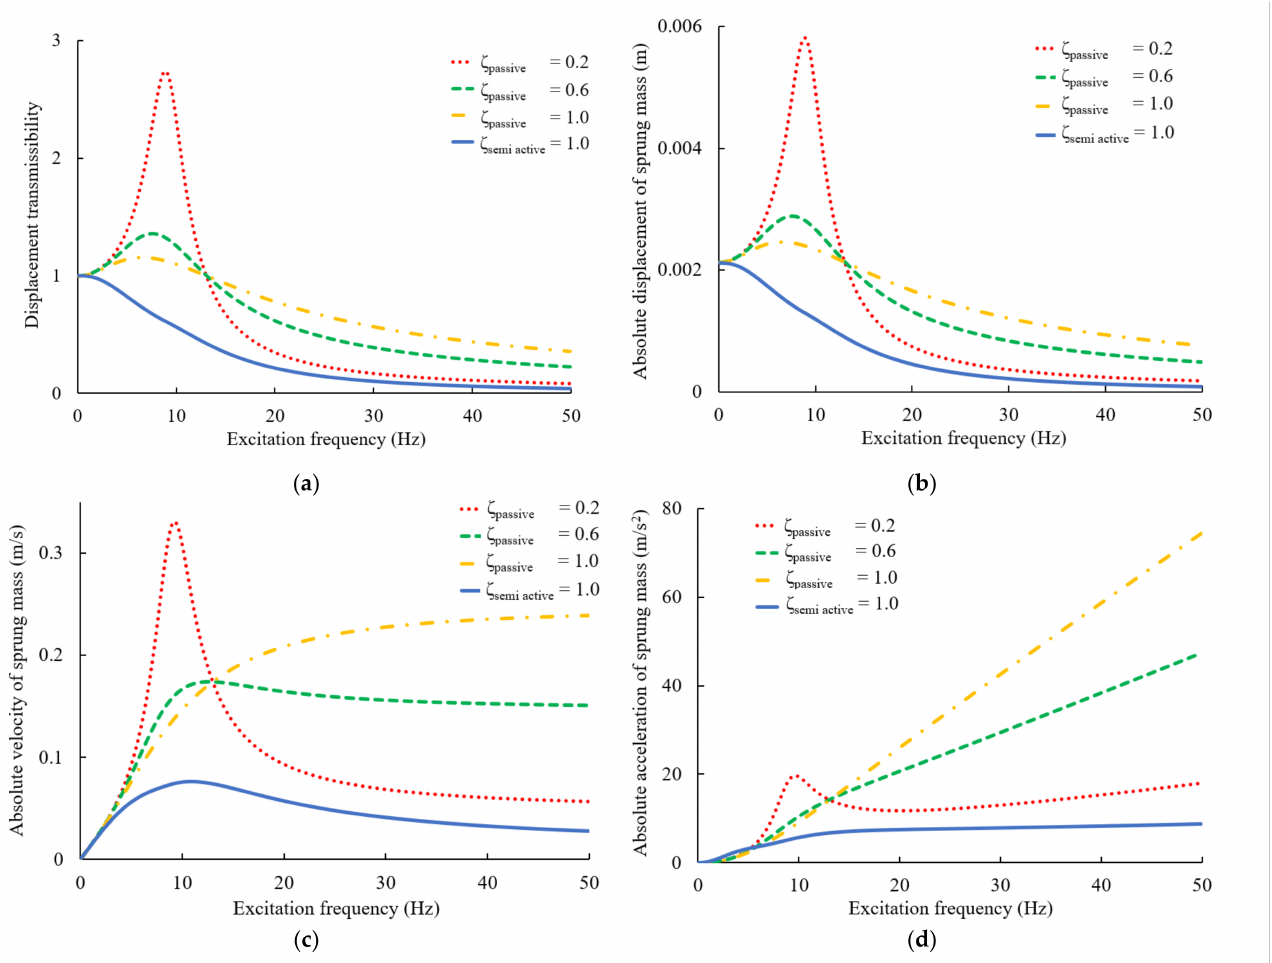
Figure 7. Response of the frequency domain: ( a ) transmissibility, ( b ) absolute displacement, ( c ) abso- lute velocity, and ( d ) absolute acceleration of the sprung